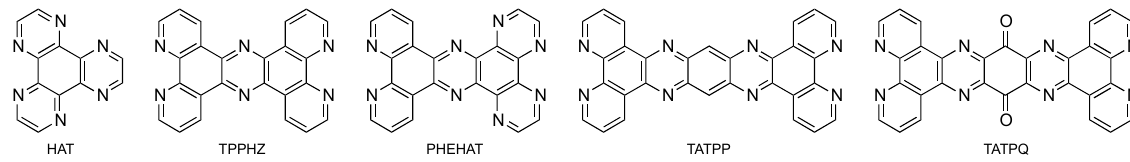
Figure 19. Examples of ligands with extended π